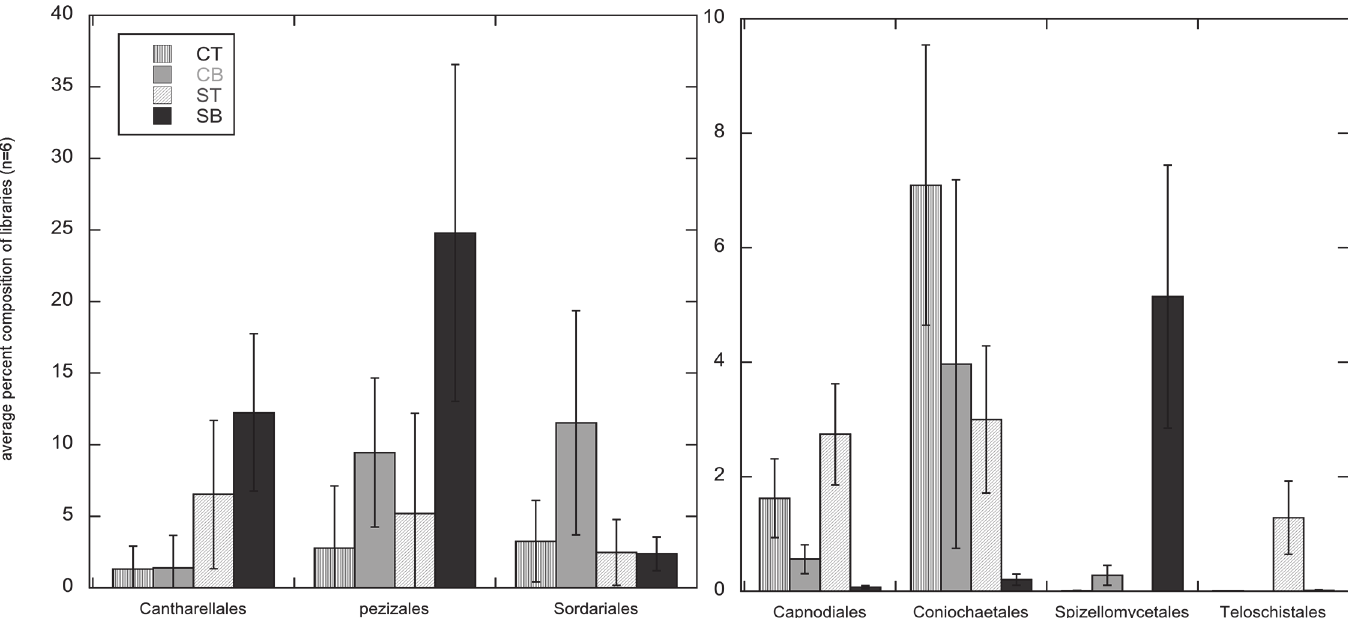
Figure 4. Average percentage of sequences (n = 6 ( ± 1 standard error)) from each soil fraction type that classified into seven of the most abundant orders for which abundance was significantly impacted by vegetation type, depth or their interaction ( P -values < 0.05; Table 3). Soil intervals and sequence libraries from them are designated as CT (cheatgrass 0 – 4 cm), CB (cheatgrass 4 – 8 cm), ST (sagebrush 0 – 4 cm) and SB (sagebrush 4 – 8 cm). Note the differences in the scale of the y-axes in the two panels. Teloschistales was not detected in the CB fractions; other fractions for which there is no visible data had percentages less than